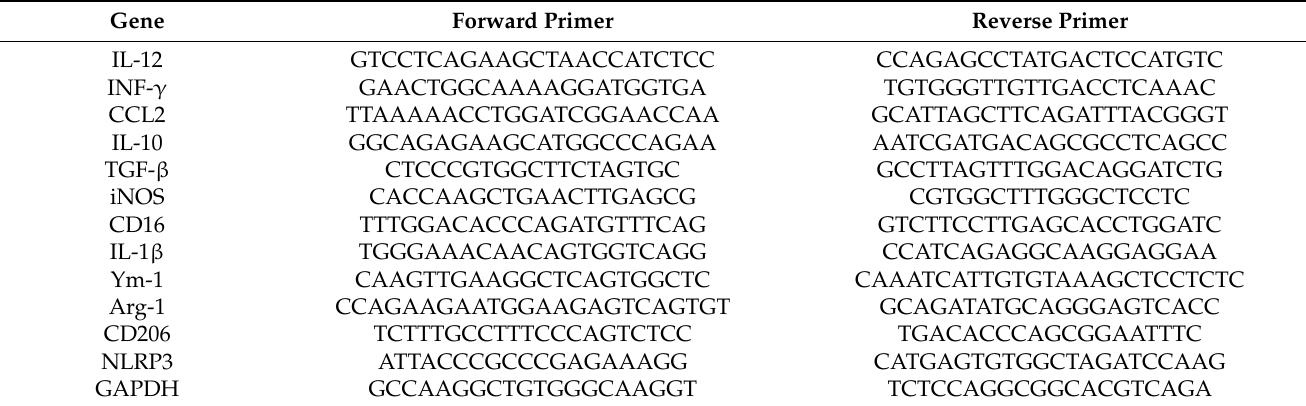
Table 2. Summary of Primer Sequences for Real-Time Polymerase Chain